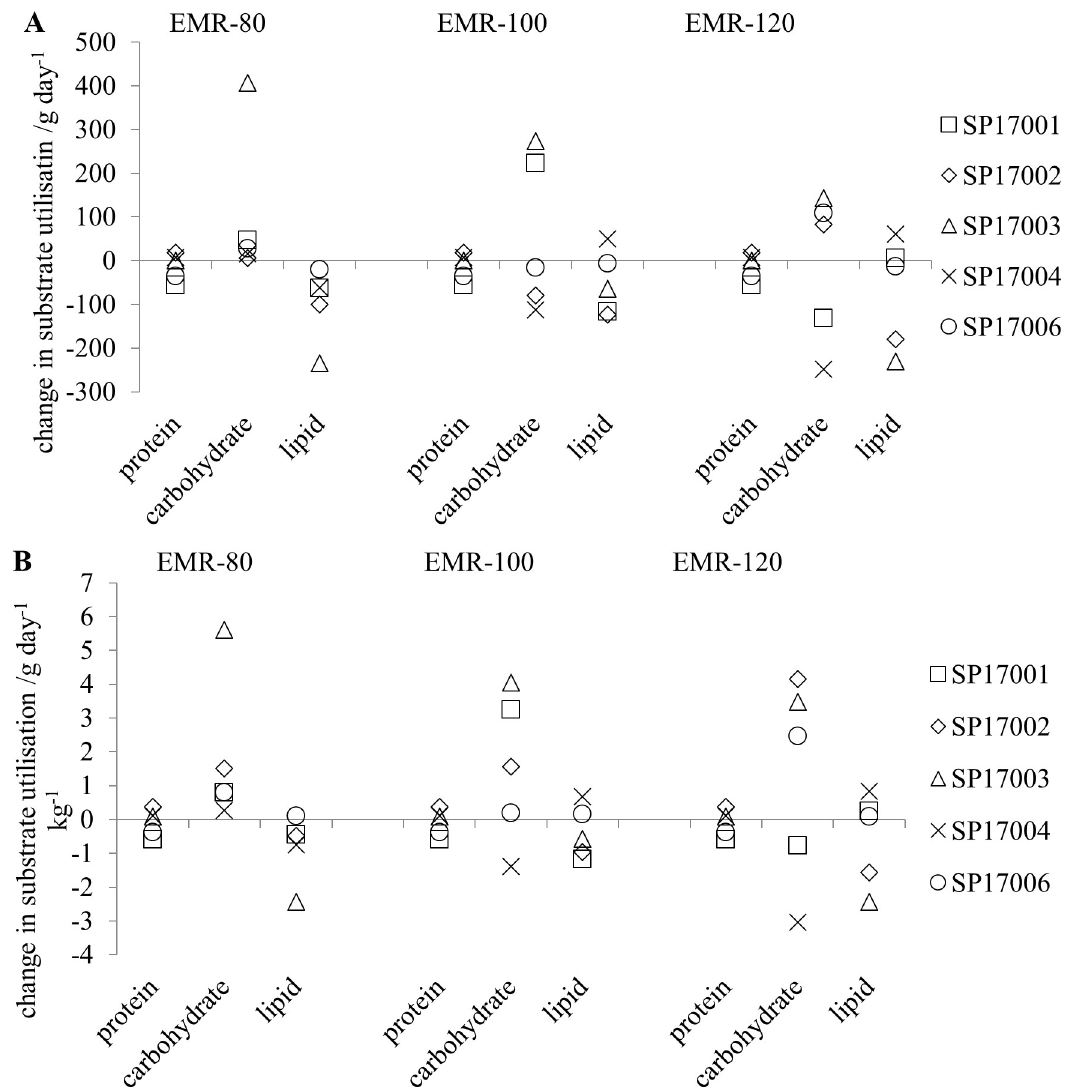
Fig 7. The change in substrate utilisation during the three periods of exercise (post-expedition–pre-expedition) where EMR-80, EMR-100 and EMR-120 are the measurements at 80 steps min -1 , 100 steps min -1 and 120 steps min -1 , respectively. (A) raw values; (B) the values normalised to body